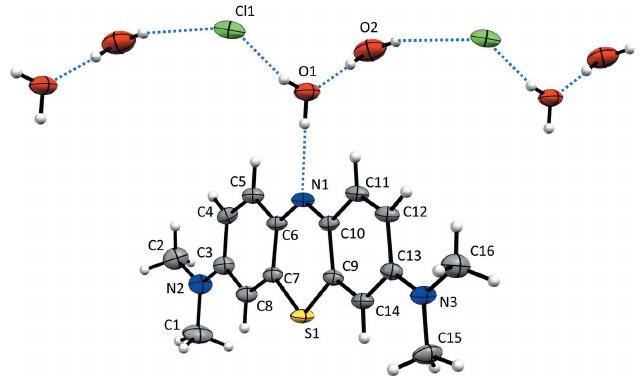
Figure 1 The molecular structure of compound ( I ), with the atom labelling.